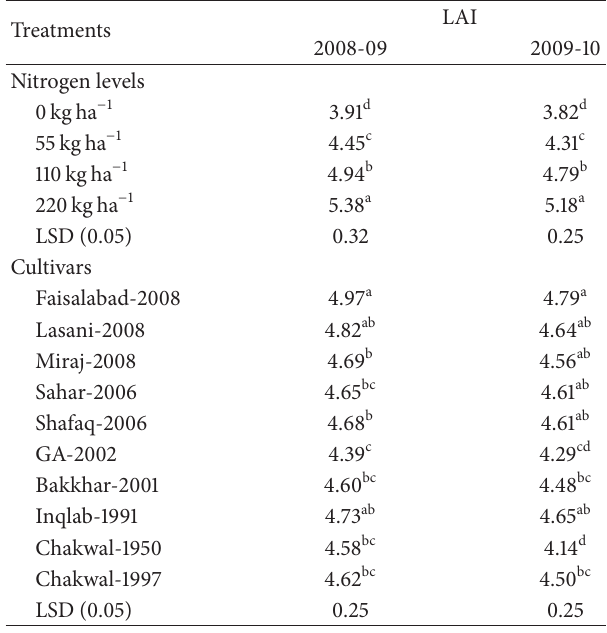
Table 3: Effect of nitrogen levels and cultivars on peak LAI at booting